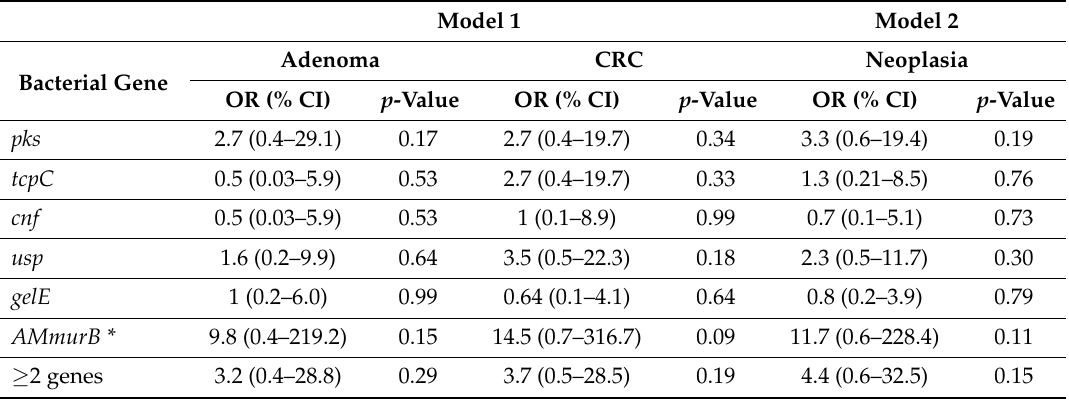
Table 4. Odds ratio (OR) estimation for the association between the presence of gut bacterial toxin genes in stool samples from individuals in the U.S. and colorectal neoplasia ( n = 30).